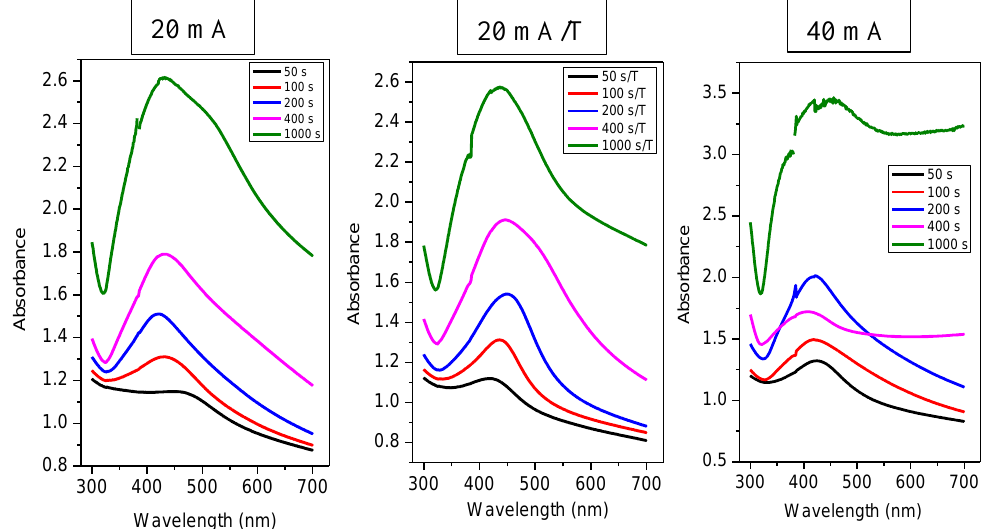
Figure 6. UV-VIS spectrum of Ag layers on PDMS—a comparison of different deposition times at constant current (20 and 40 mA) or with the following thermal treatment (20 mA/T).